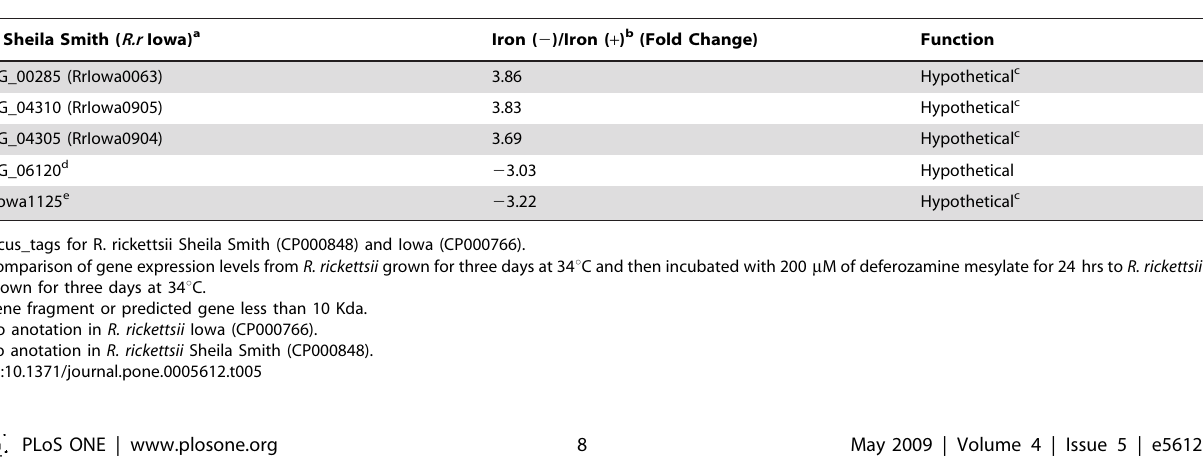
Table 5. Transcriptional response to limiting iron conditions.